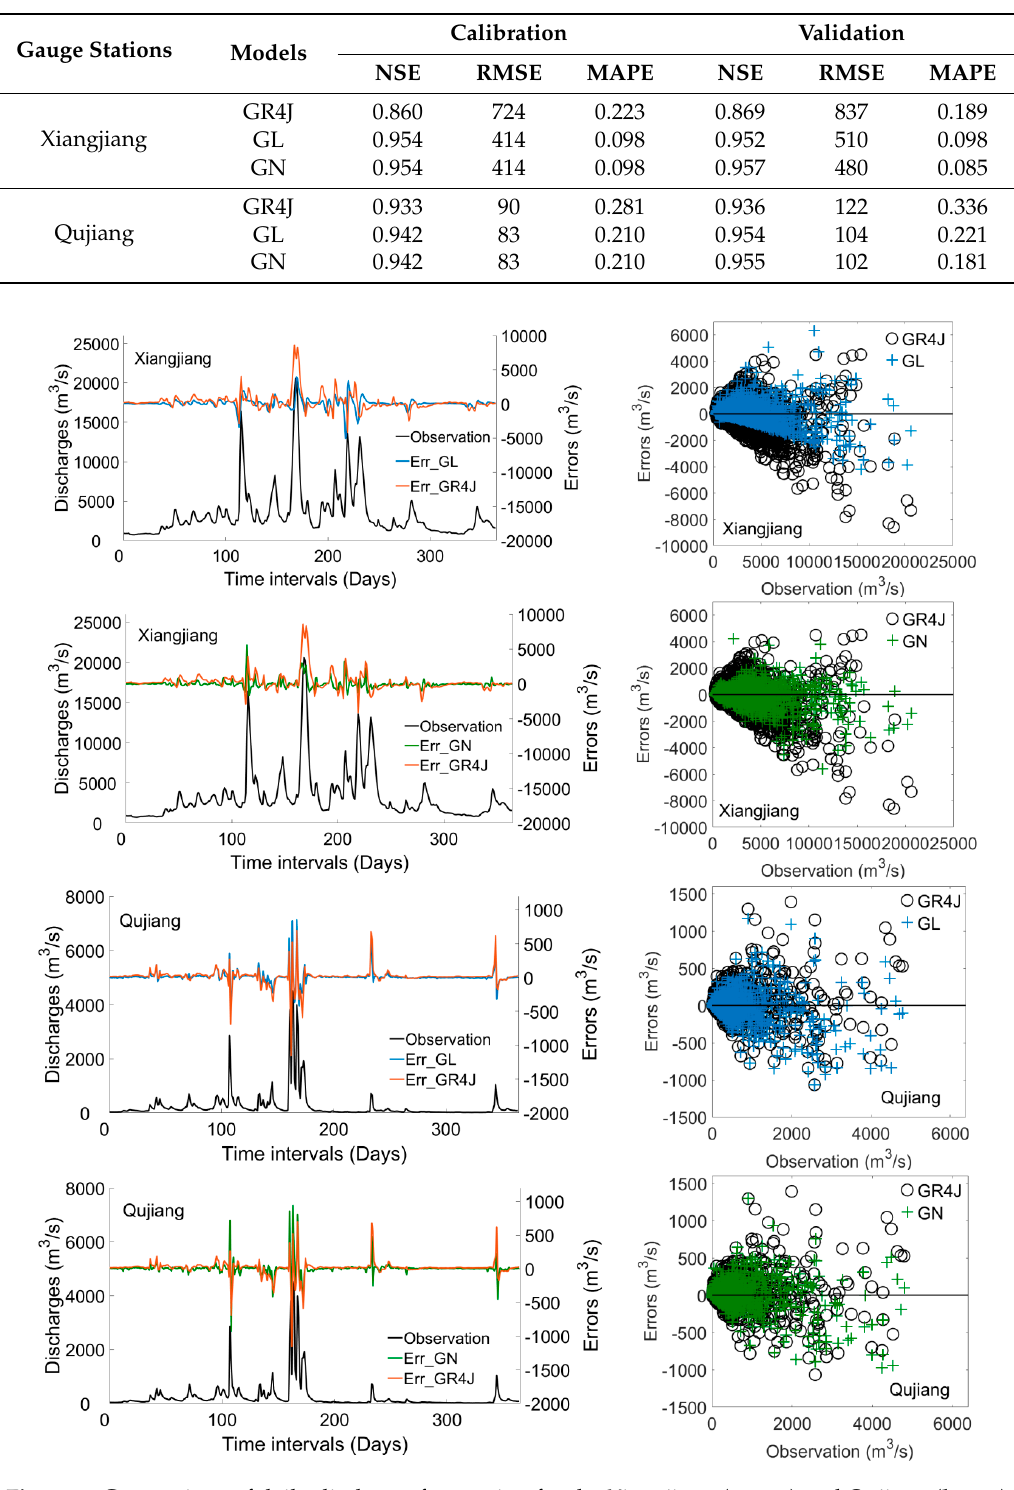
Figure 3. Comparison of daily discharge forecasting for the Xiangjiang ( upper ) and Qujiang ( lower ) basins between GR4J and the GR4J hydrological model integrated with LSTM (GL) ( above ) and GR4J and the GR4J hydrological model integrated with NARX (GN) ( below ).